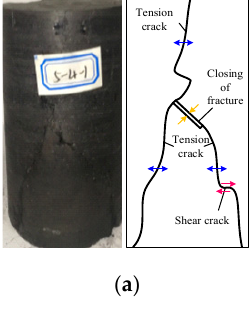
Figure 7. A 3 MPa confining pressure with different numbers of prefabricated cracks in coal speci- men failure mode and its sketch. ( a ) M-3-1; ( b ) M-3-2; ( c ) M-3-3; ( d ) M-3-4. failure mode and its sketch. ( a ) M-3-1; ( b ) M-3-2; ( c ) M-3-3; ( d )